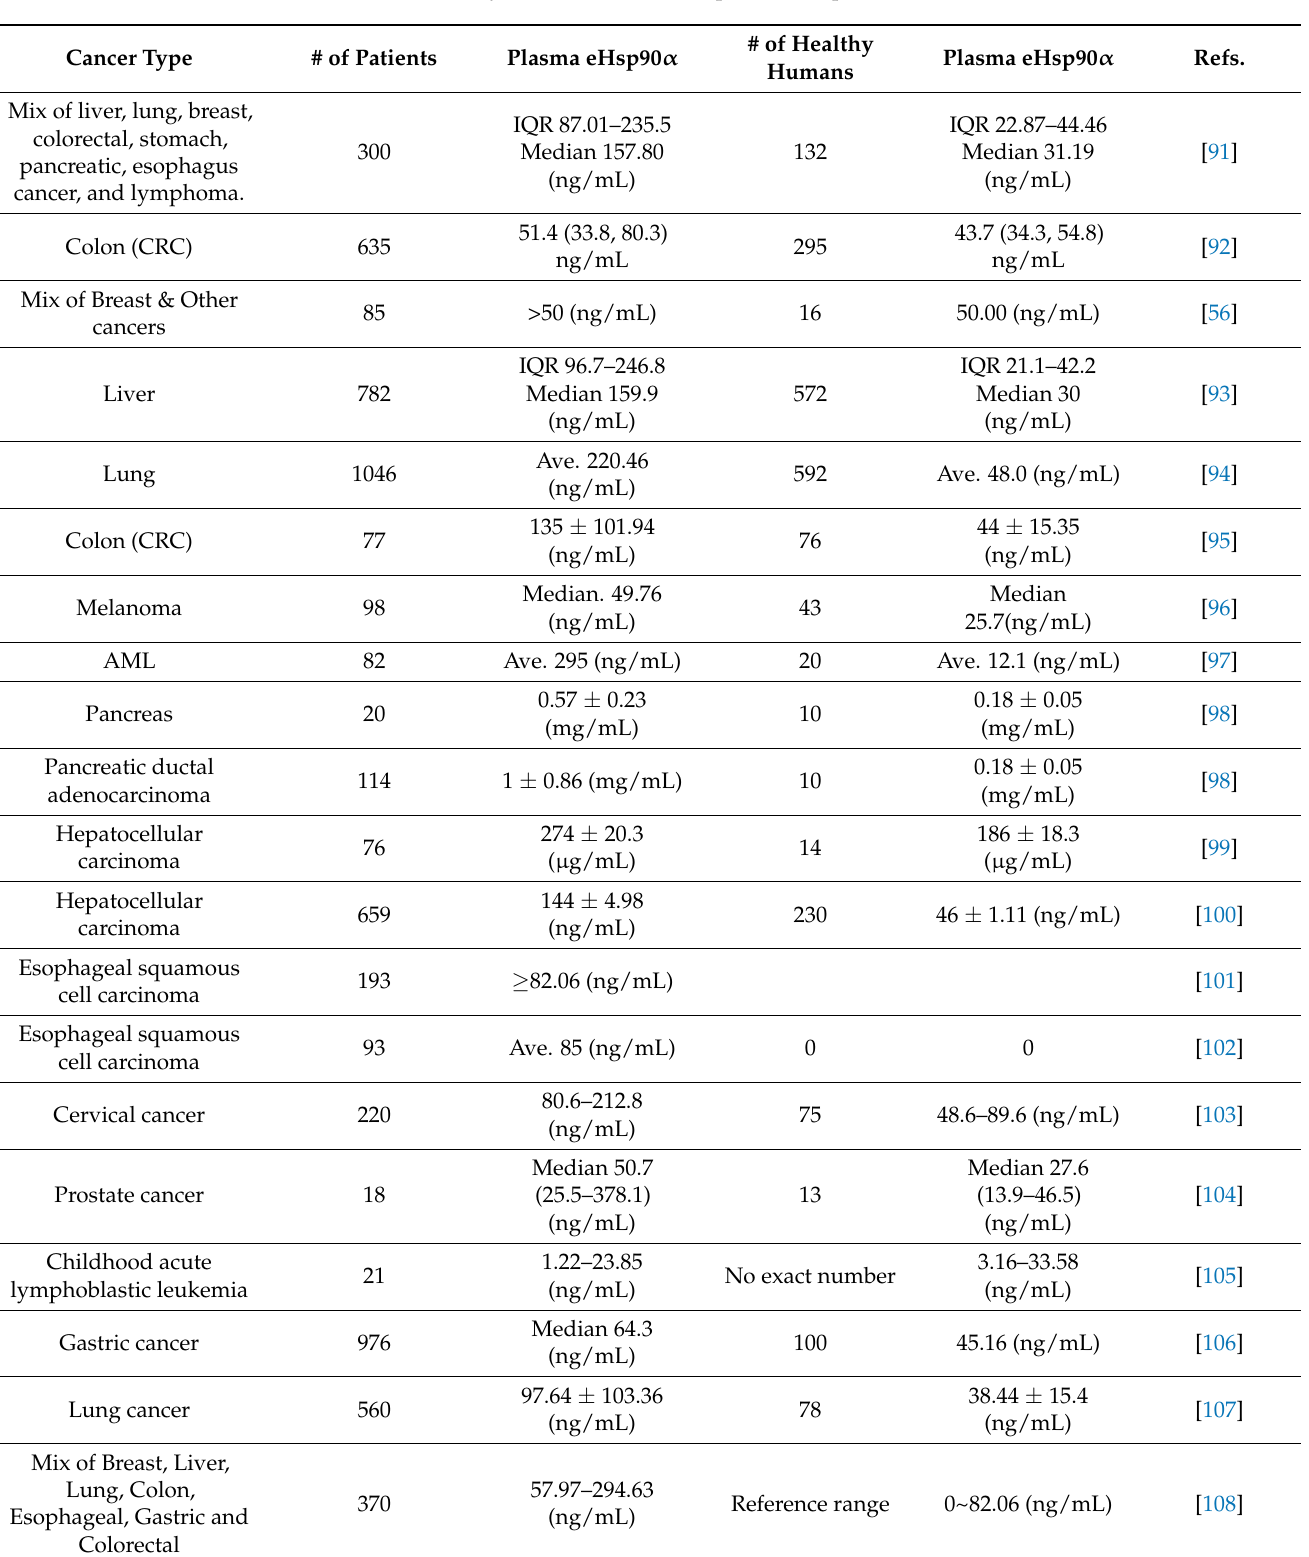
Table 1. Summary of clinical studies on plasma eHsp90 in blood circulation